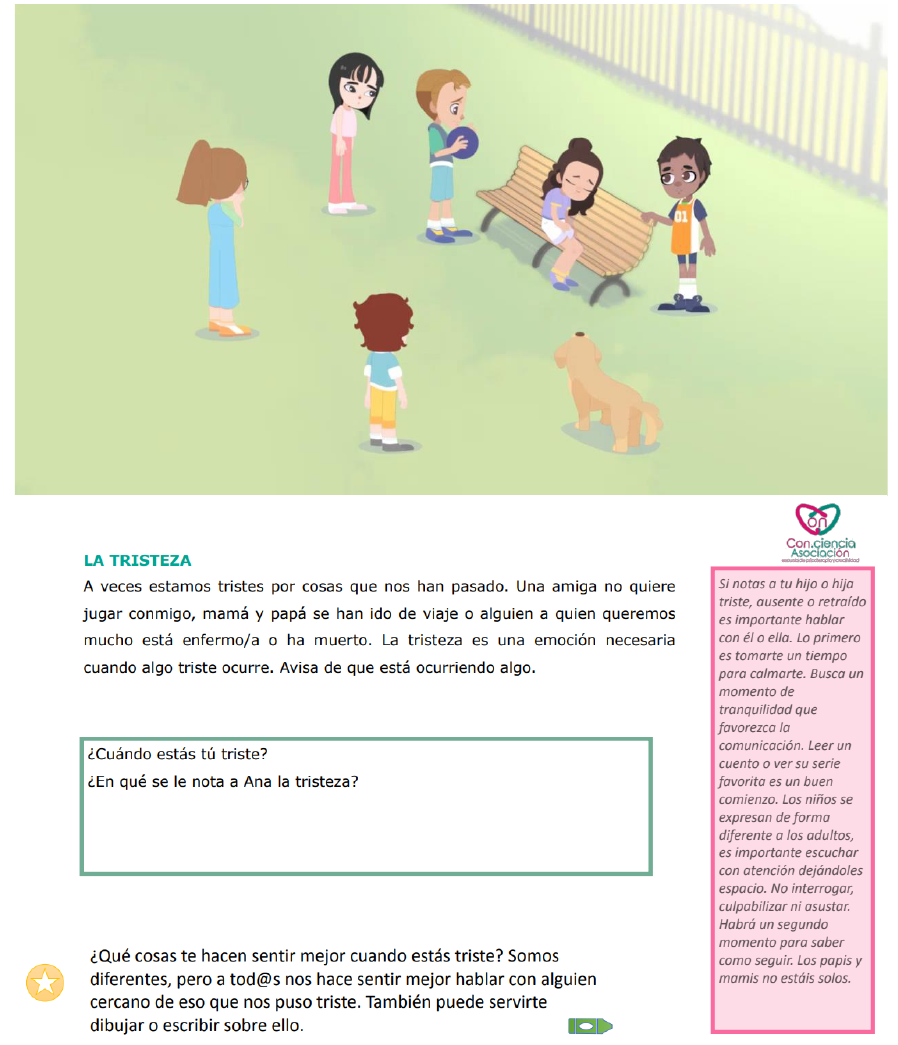
Figure 1. Example of an activity from the workbook about sadness.